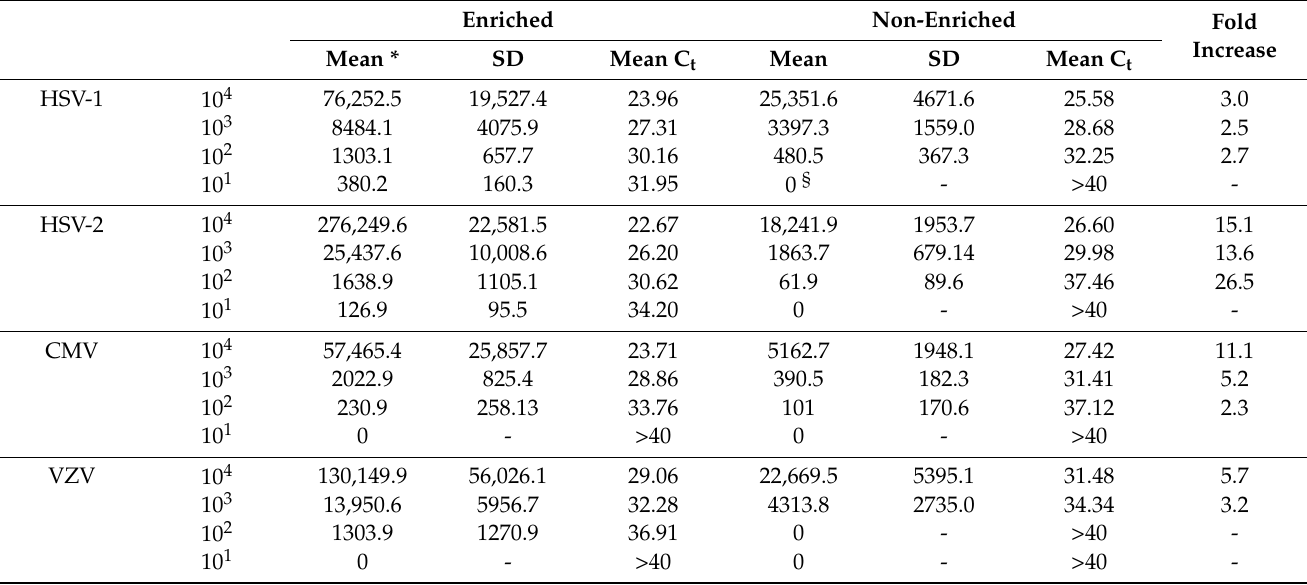
Table 2. Mean and standard deviations (in cp/mL), as well as mean Ct value, for both the enriched and non-enriched samples of each pathogen at the 4 concentrations tested (10 4 to 10 1